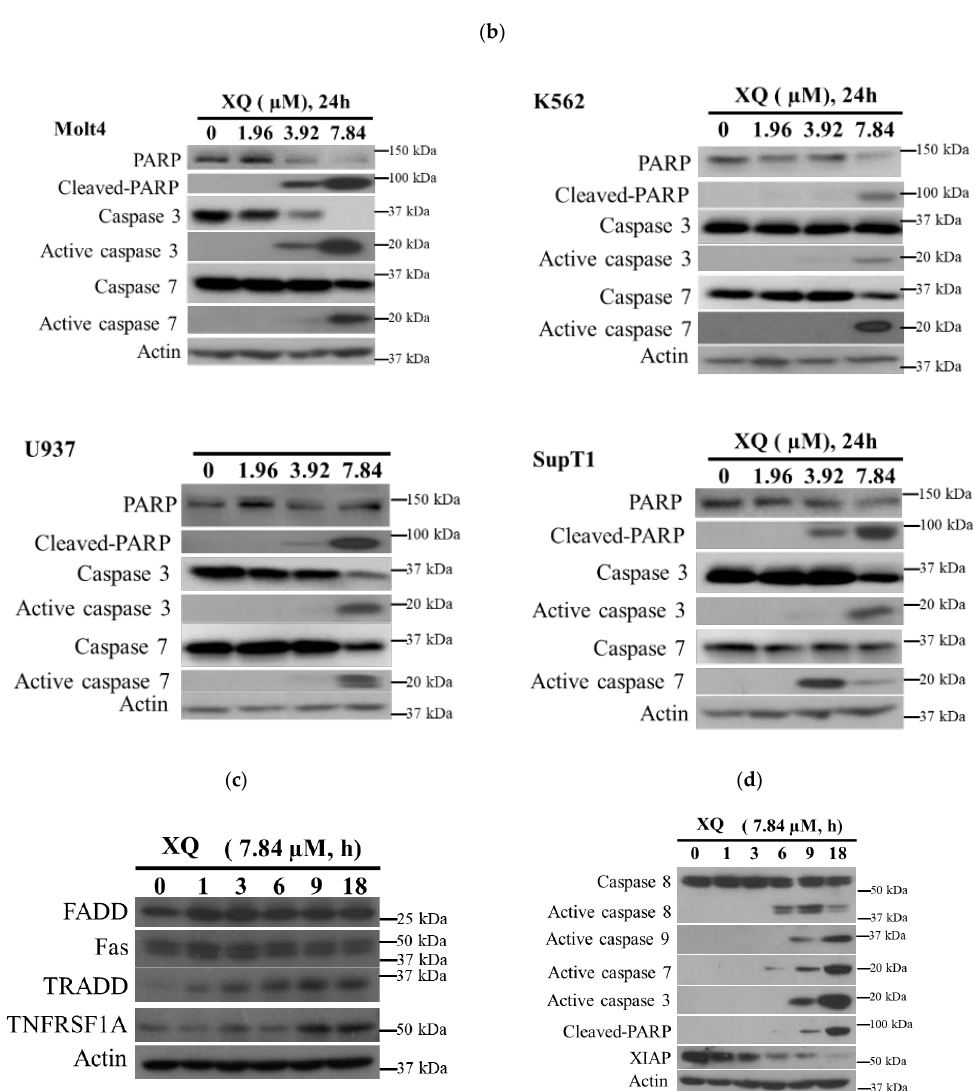
Figure 5. Xestoquinone induced cell apoptosis in Molt4, K562, SupT1, and U937 human leukemia cells. Leukemia cells were treated with XQ for 24 h. ( a ) The annexin V externalization was detected by flow cytometry. ( b ) Caspases-3 and -7 and PARP protein levels were detected by Western blotting. ( c ) The protein levels of death receptors, including FADD, Fas, and TRADD, were detected by Western blotting. ( d ) The effect of XQ on the expression of apoptosis-related proteins was determined by Western blotting analysis. Actin was used as the loading control.